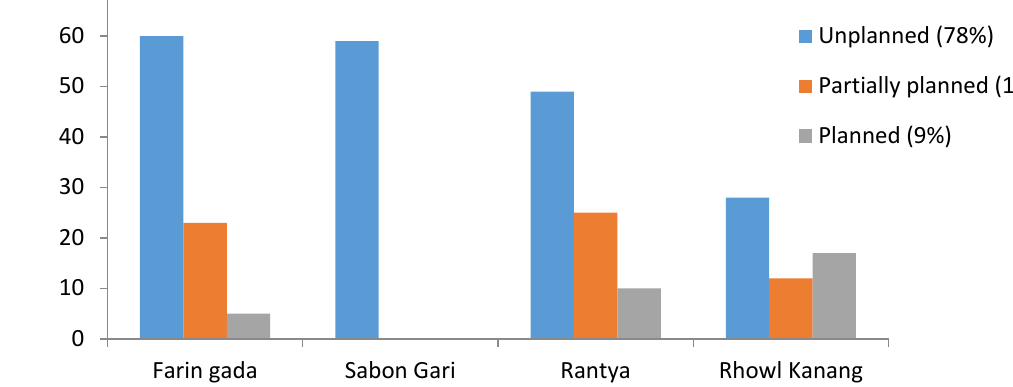
Fig. 7: The nature of growth in peri-urban areas of Jos